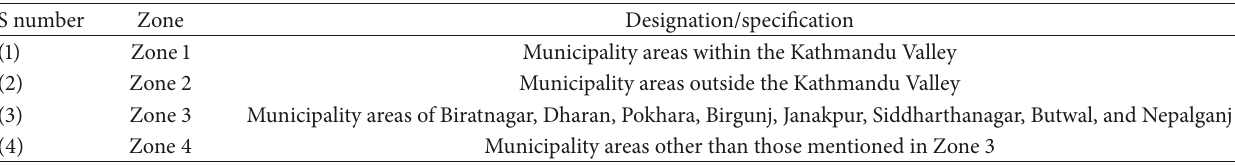
Table 1: The categorization of the four industrial zones of